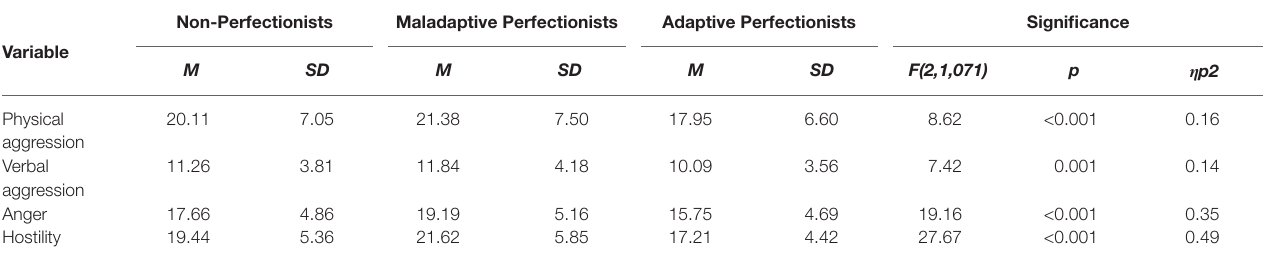
TABLE 3 | Mean scores, SDs, and post hoc contrasts obtained by the perfectionist classes on the different manifestations of aggression behavior. Non-Perfectionists